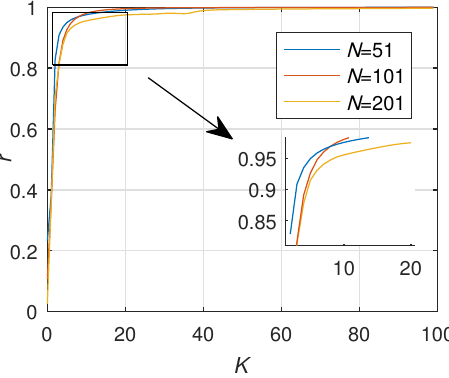
Figure 23. Synchronization progress when N is 51,101,201 in case 3.